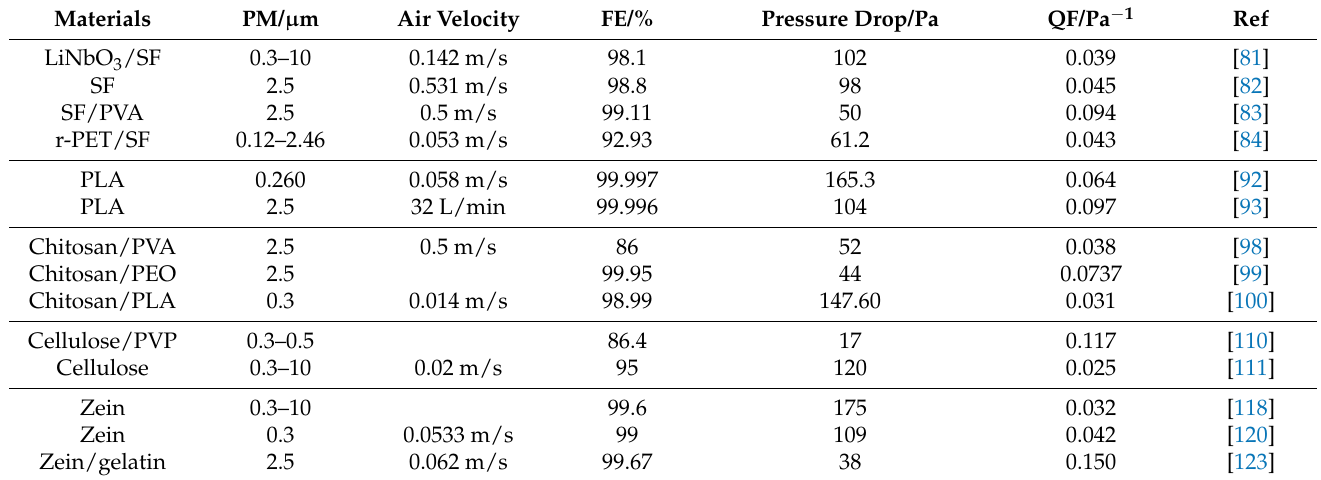
Table 1. Summary of biodegradable nanofiber filters for air